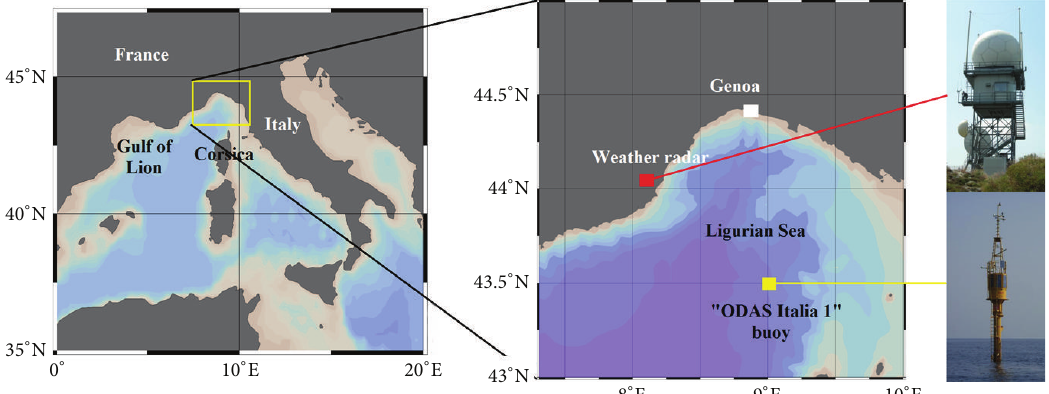
Figure 1: Map of the working area of the LiSAE experiment and zoom indicating the position of the weather radar and the “ODAS Italia 1”